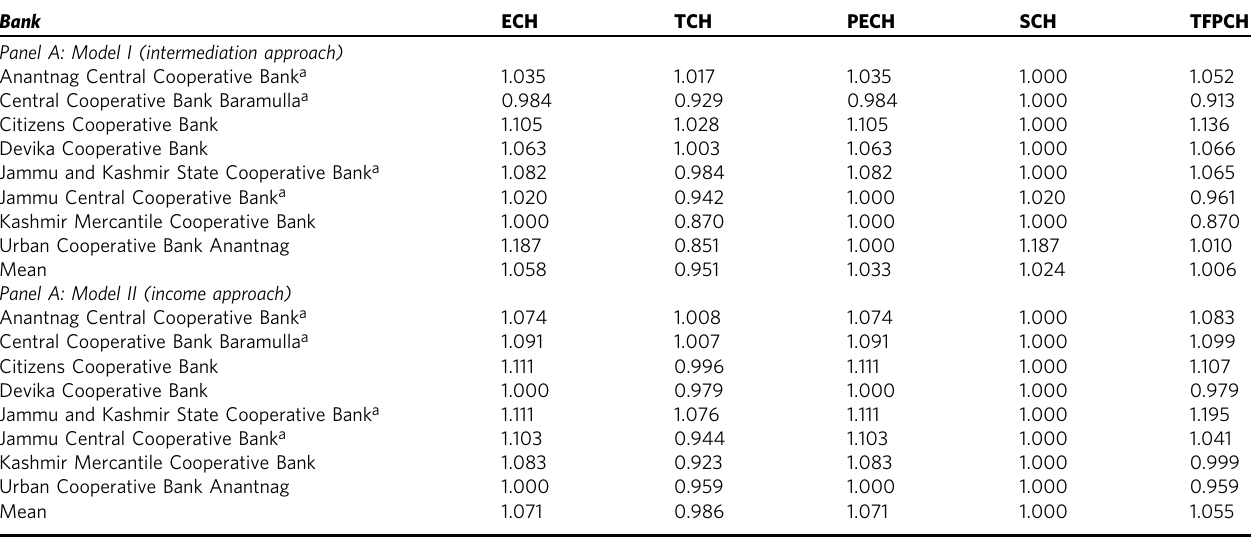
Table 3 Total factor productivity of Jammu and Kashmir Cooperative Banks. Bank ECH TCH PECH SCH TFPCH Panel A: Model I (intermediation approach) Anantnag Central Cooperative Bank